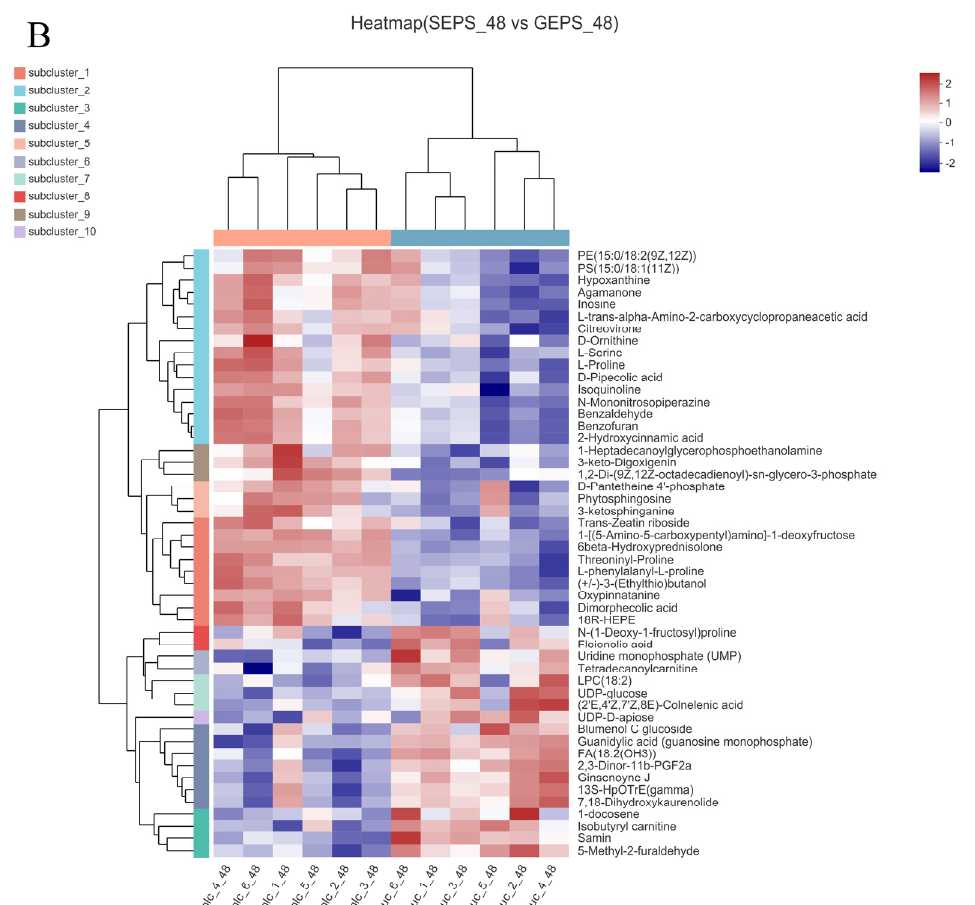
Figure 4. Analysis of DEMs in SEPS_48 and GEPS_48 comparison groups. ( A ) Number of up − and downregulated DEMs in the SEPS_48 and GEPS_48 comparison groups. Red dots represent upregulated metabolites, blue dots represent downregulated metabolites. ( B ) Heatmap of the DEMs in the SEPS_48 and GEPS_48 comparison groups. Red indicates highly expressed genes and blue indicates less − expressed genes.